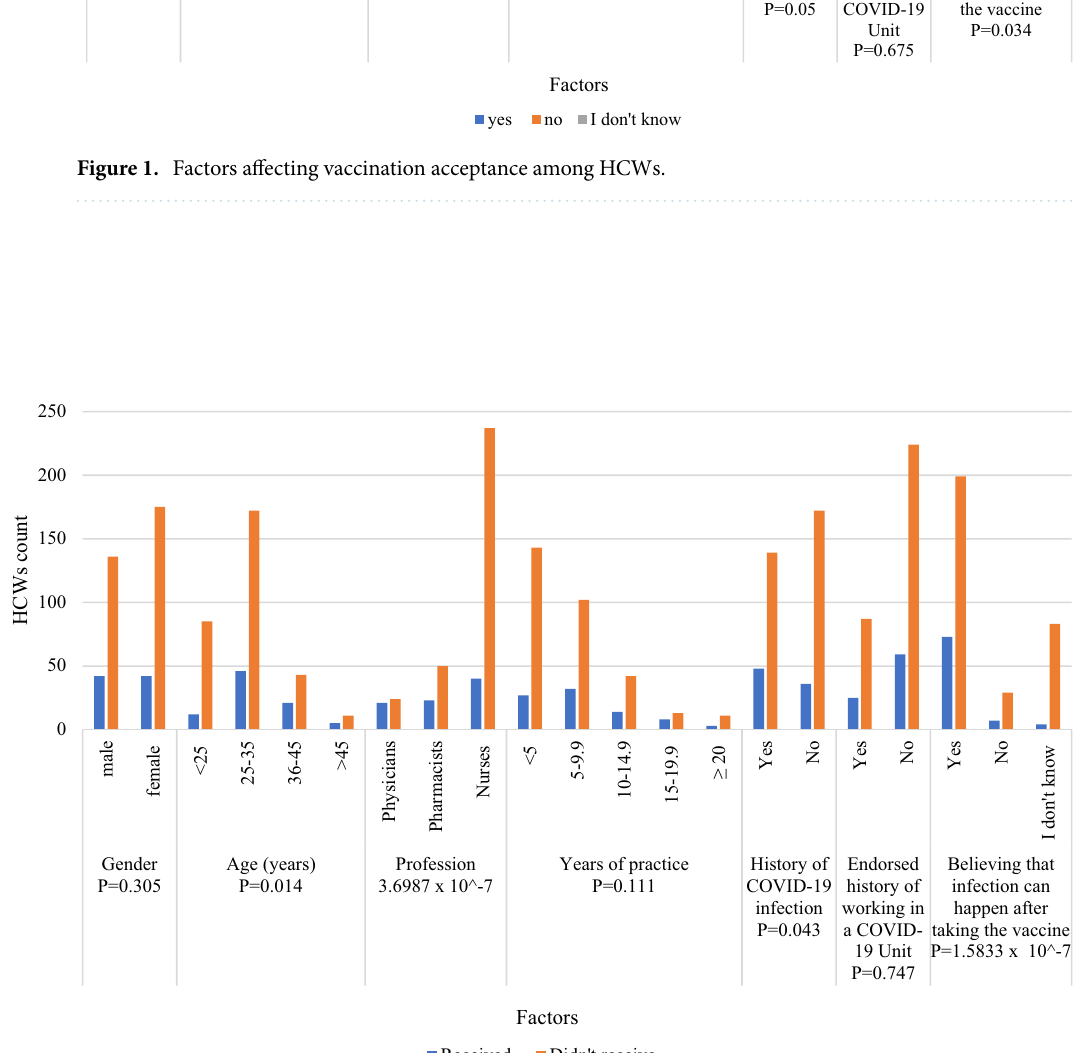
Figure 2. Factors affecting receiving at least one dose of a COVID-19 vaccine among